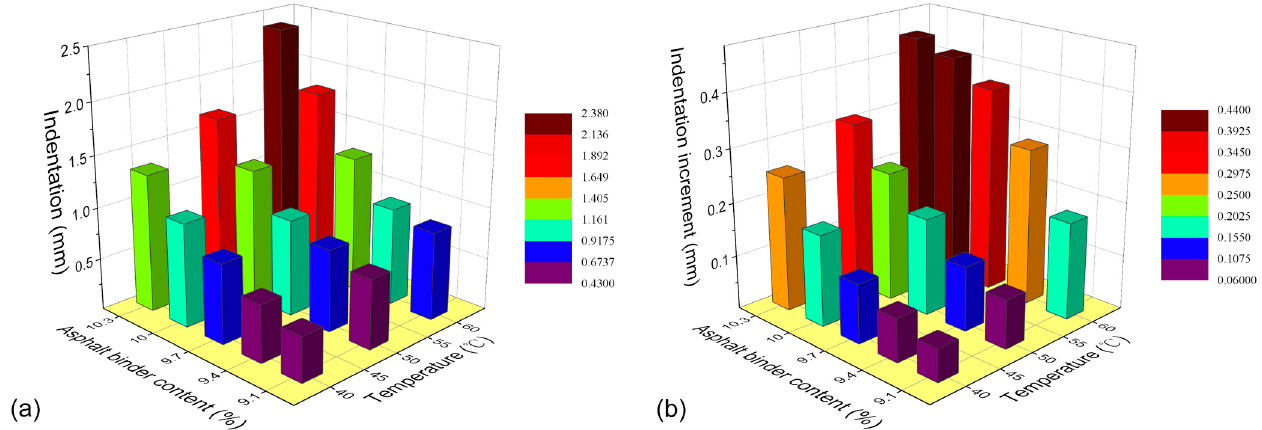
Figure 5. Influence of asphalt content on ( a ) indentation and ( b ) the indentation